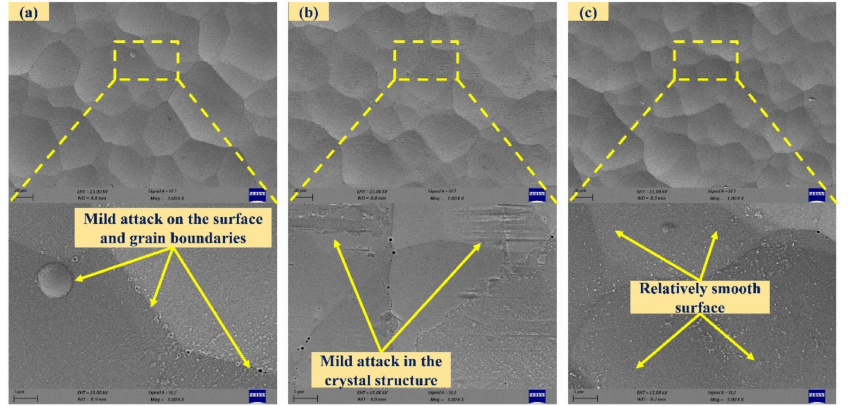
Figure 9. SEM images of chemically treated surfaces with 1% hydrofluoric acid (( a – c ): exposure times of 10, 20, and 30 min).